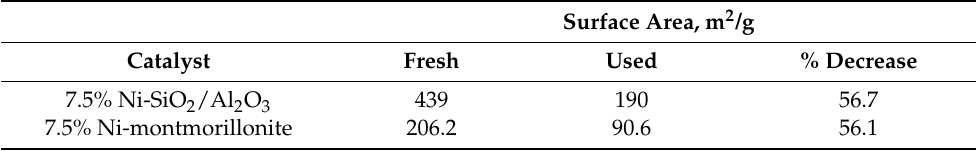
Table 9. Surface area of fresh and used